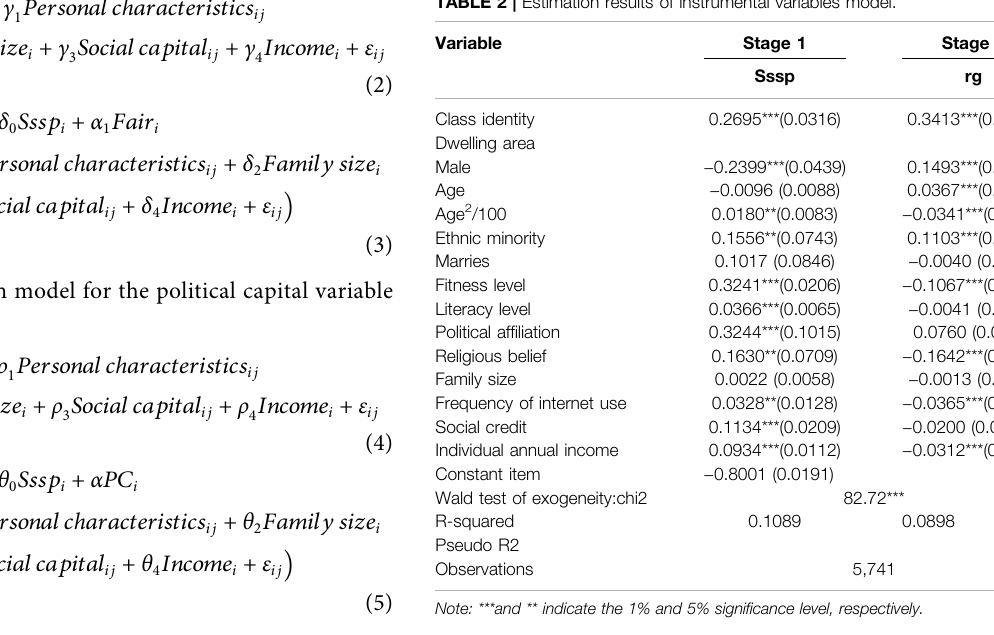
TABLE 2 | Estimation results of instrumental variables